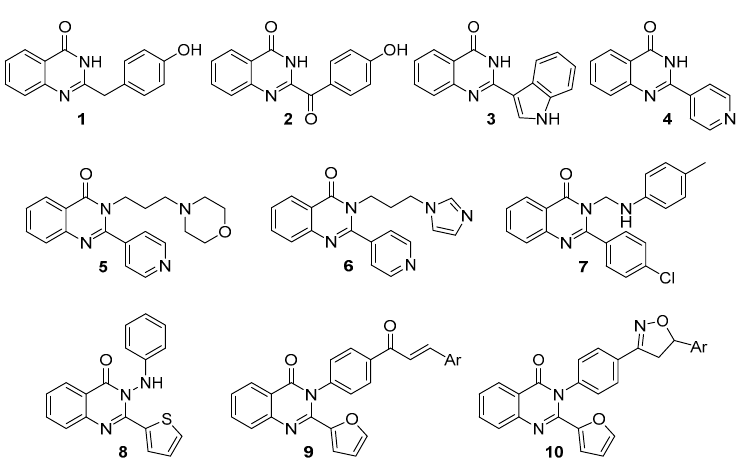
Figure 1. Examples of quinazolinones with antiviral and anticancer activity.